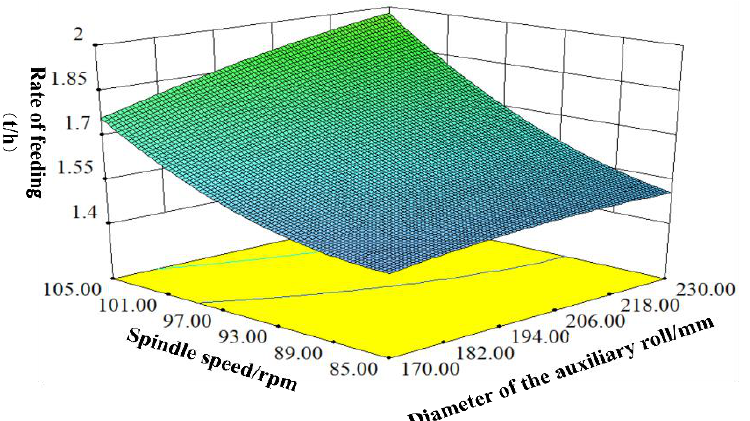
Figure 10. Influence of spindle speed and auxiliary roller diameter on feeding rate.